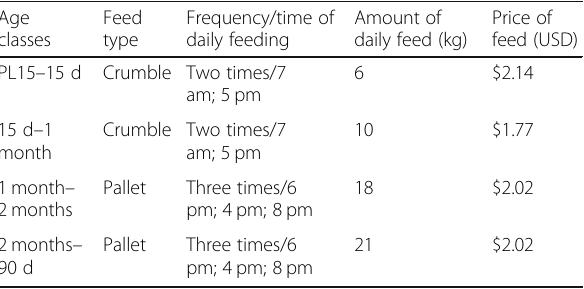
Table 2 Feed and feeding schedule during shrimp culture